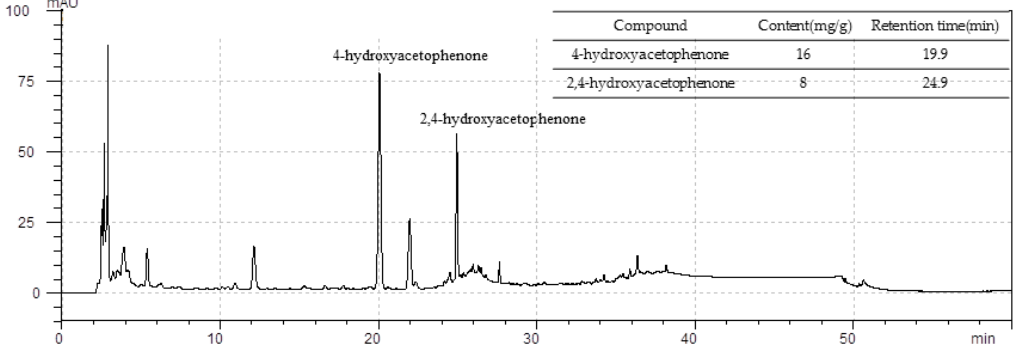
Figure 7. Representative high-performance liquid chromatography (HPLC) chromatograms of aqueous Cynanchum wilfordii extract (CWW). Mobile phase consisted of solvents A (methanol) and B (0.1% formic acid) run at a flow rate of 1.0 mL/min. Elution conditions were as follows: 0–5 min, 20% A; 5–12 min, 20–30% A; 12–20 min, 30–40% A; 20–25 min, 40–80% A; 25–35 min, 80–100% A; 35–46 min, 100% A; 46–50 min, 100–20% A; 50–60 min, 20%; and finally, the column was washed and reconditioned. Sample injection volume was 20 µ L. Optimum HPLC separation was achieved at 35 ◦ C and monitored at 284 nm. AU: arbitrary unit.